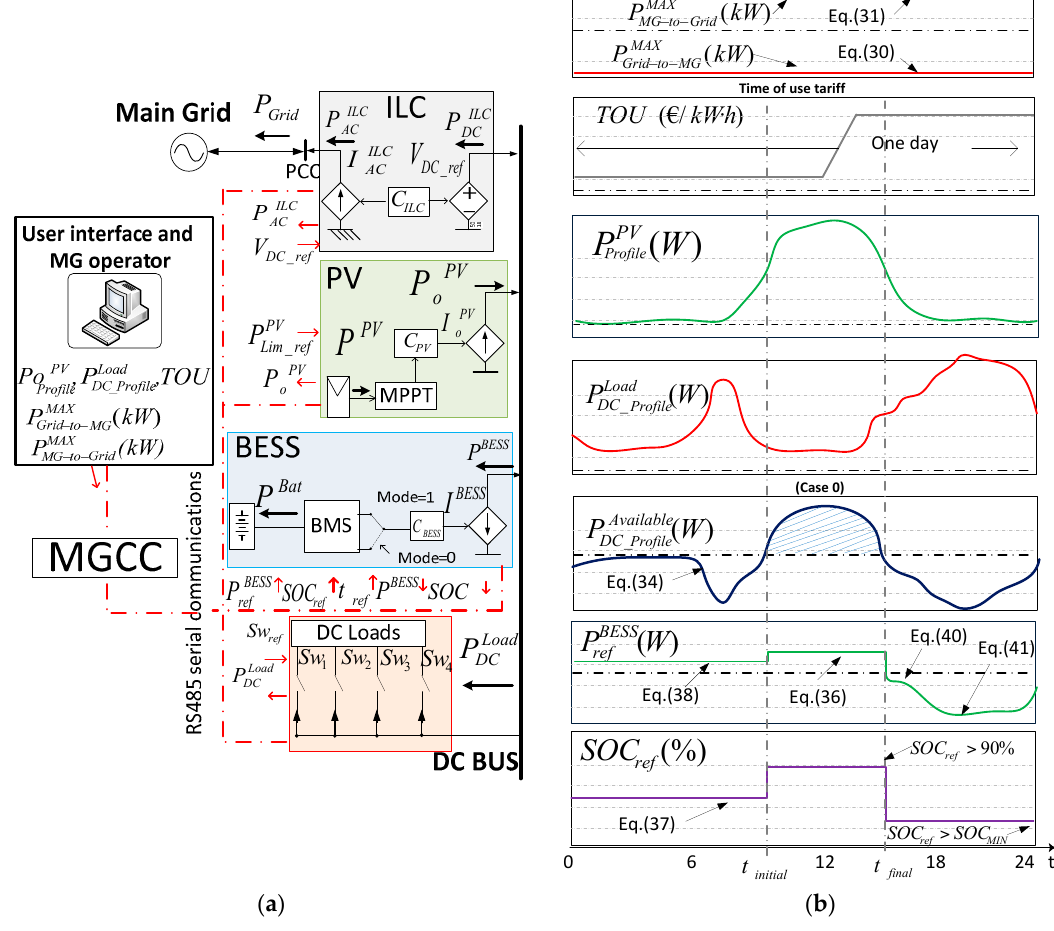
Figure 9. DC microgrid implemented: ( a ) Placement of the power converters operating in the DC microgrid; ( b ) Graphics of the power profiles and of the charge process of the batteries (Case 0). Table 5. Parameters broadcasted between the power converters of the DC microgrid and the MGCC.